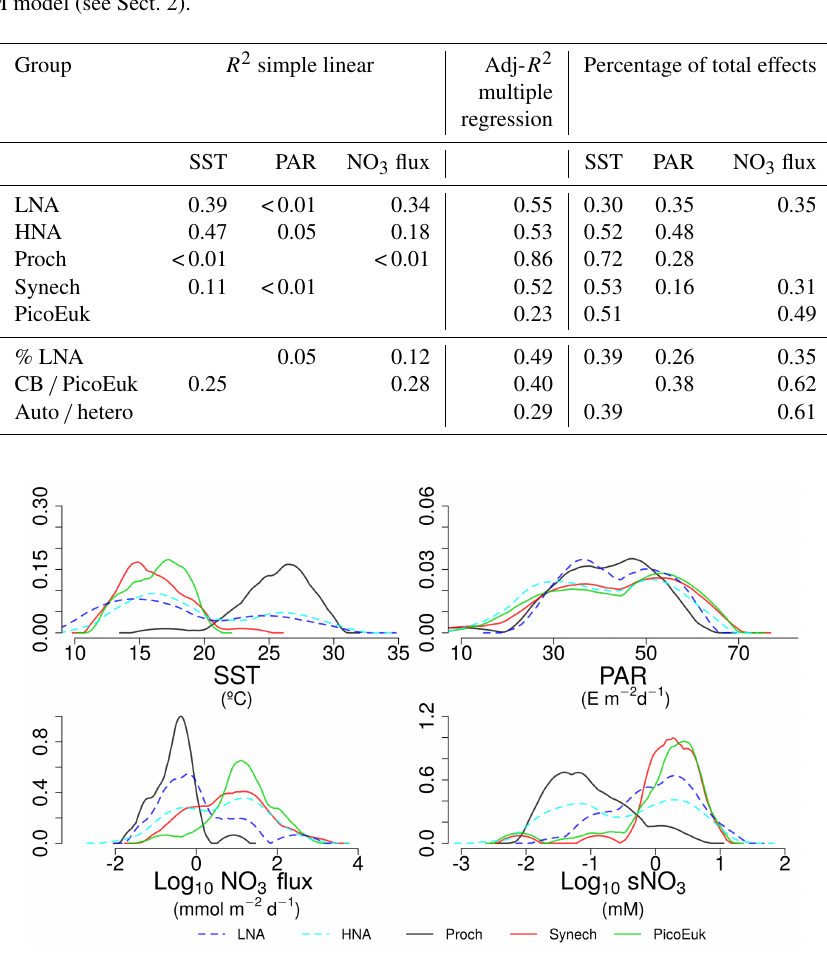
Table 3. Simple ( R 2 ) and adjusted squared correlation coefficients (Adj- R 2 ) for simple linear regression and multiple generalized additive models (GAMs) built to predict depth-integrated biomass for each picoplankton subgroup, the contribution of LNA bacteria to total het- erotrophic picoplankton biomass (% LNA), the ratio of cyanobacteria ( Prochlorococcus + Synechococcus ) to picoeukaryote depth-integrated biomass (CB / PicoEuK), and the ratio of autotrophic (CB + PicoEuk) to heterotrophic bacteria (LNA + HNA) biomass based on sea surface temperature (SST), surface photosynthetically active radiation (PAR), and nitrate supply (NO 3 flux). Negative binomial distribution was assumed. Multiple model selection was based on stepwise regression and the Akaike information criterion (see Sect. 2). Only significant ( p value < 0.05) results are shown. Percentage of total effects represents the contribution of each environmental factor to the variability explained by each GAM model (see Sect. 2).